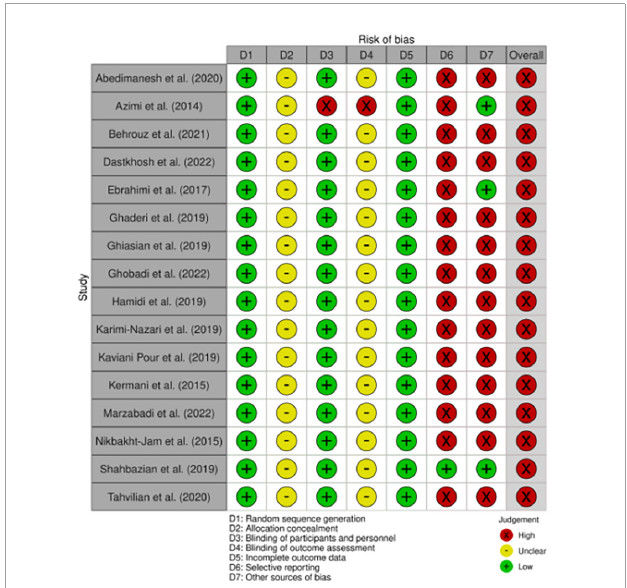
FIGURE2 Study quality and risk of bias assessment of included studies according to the Cochrane Collaboration’s tool.